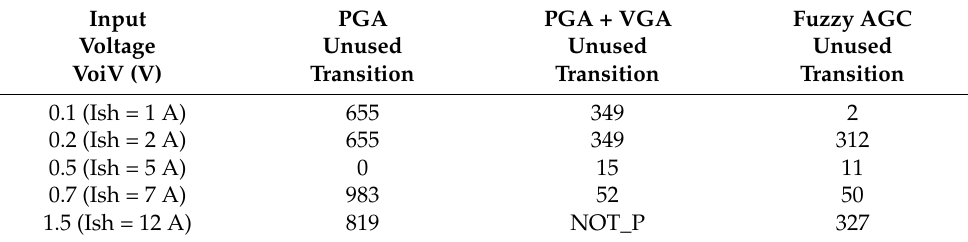
Table 1. Errors in the measurement system using a 12-bit ADC converter supplied with a reference voltage of 5 V. (PGA, gain can be programmed by 2 n with a max value 4096 and VGA, gain